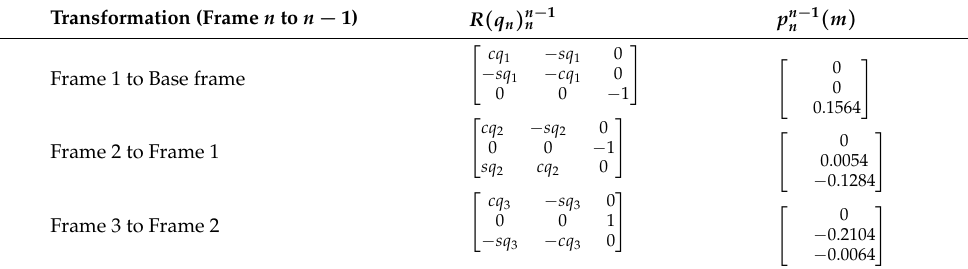
Table 2. Homogeneous transformation matrices for Kinova Gen3 7DoF robot (provided by